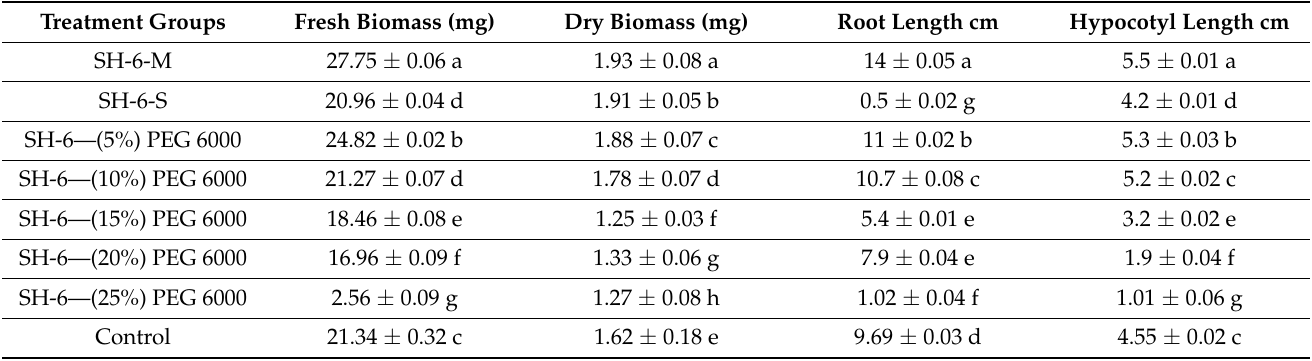
Figure 6. Germination metrics. ( A ) SVI, ( B ) GRI and ( C ) GP and GE. Each data point is the mean of 5 replicates. The latter on each bar is the significant different between treatment at p ≤ 0.5, where ND = not detected. The error bar represents the standard error among the replicates. Table 1. Seedling characteristics and biomass at day 7. The letters indicate the significant difference between treatment at p ≤ 0.5